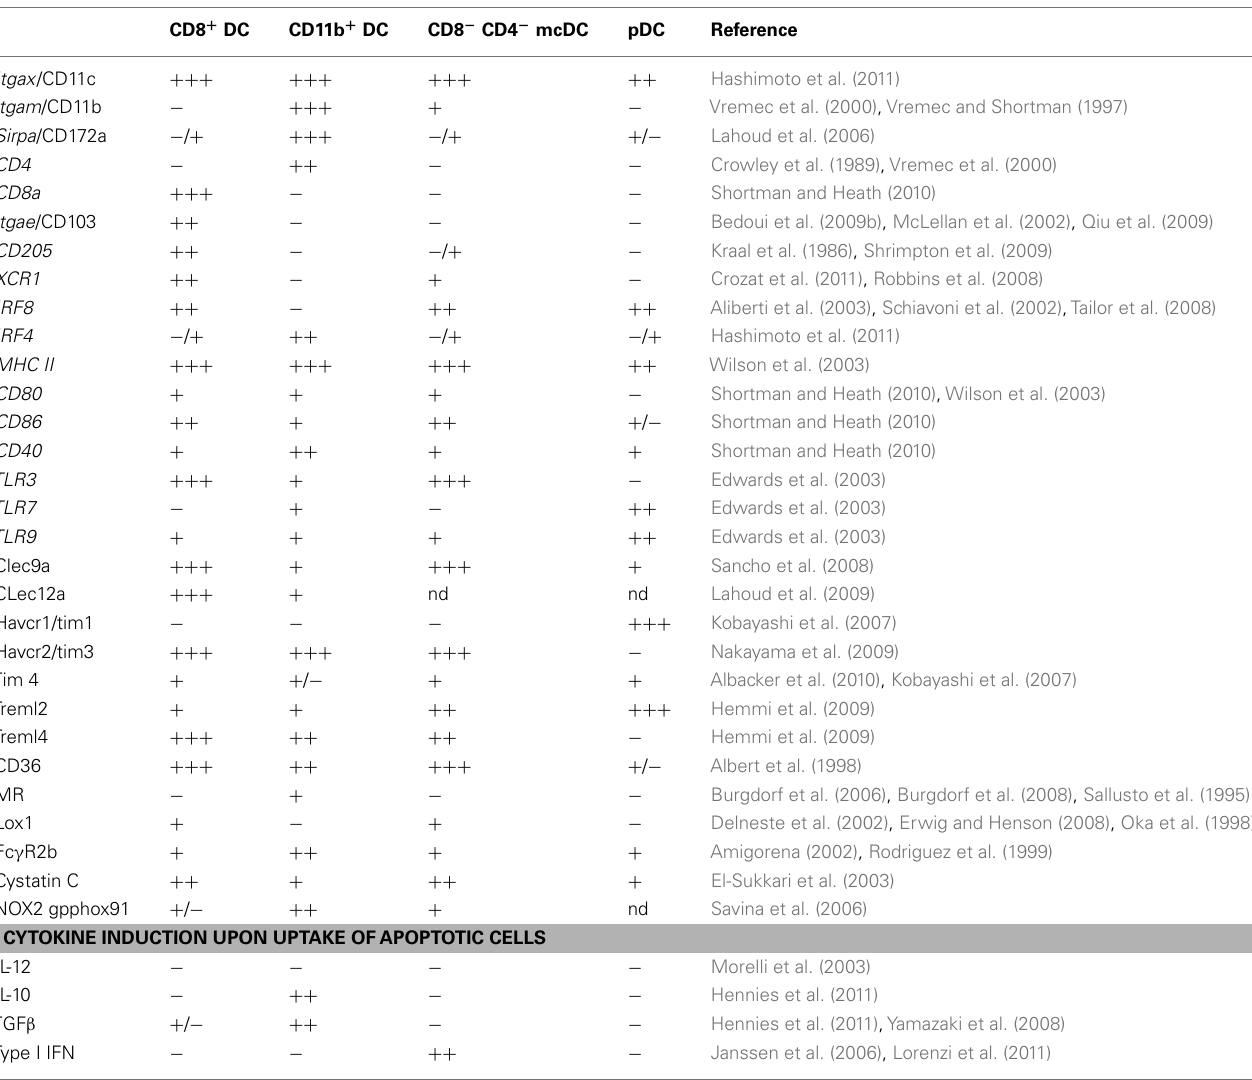
Table 1 | Characteristics of splenic DC